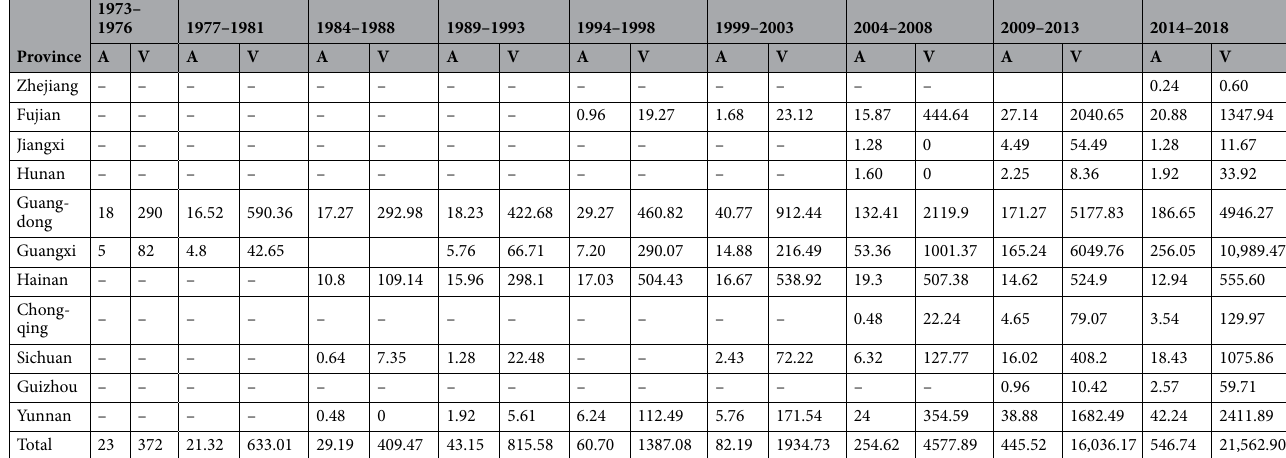
Table 1. Eucalyptus plantation area and stand volume in different time periods by province. The letters “A” and “V” refer to cover area (unit: 10 4 hm 2 ) and stand volume (unit: 10 4 m 3 ),